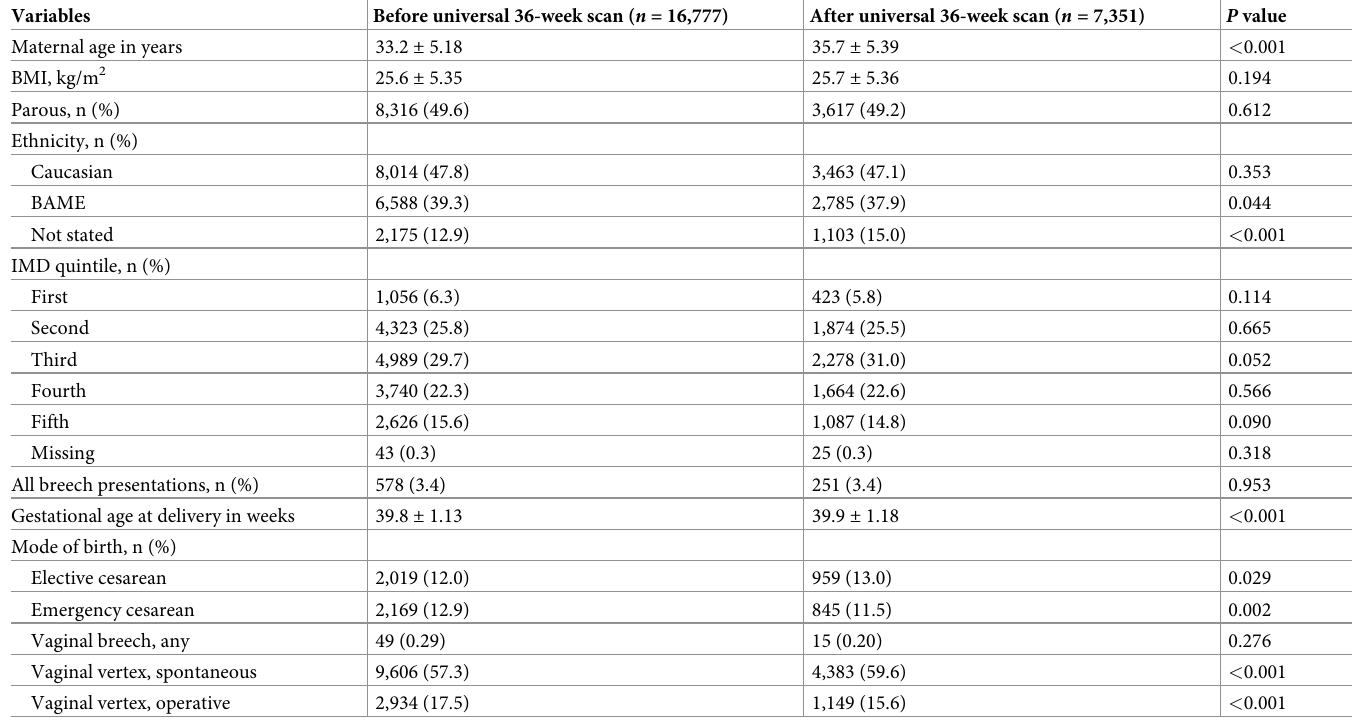
Table 1. Baseline characteristics of pregnancies in the study epochs before and after the introduction of universal 36-week ultrasound